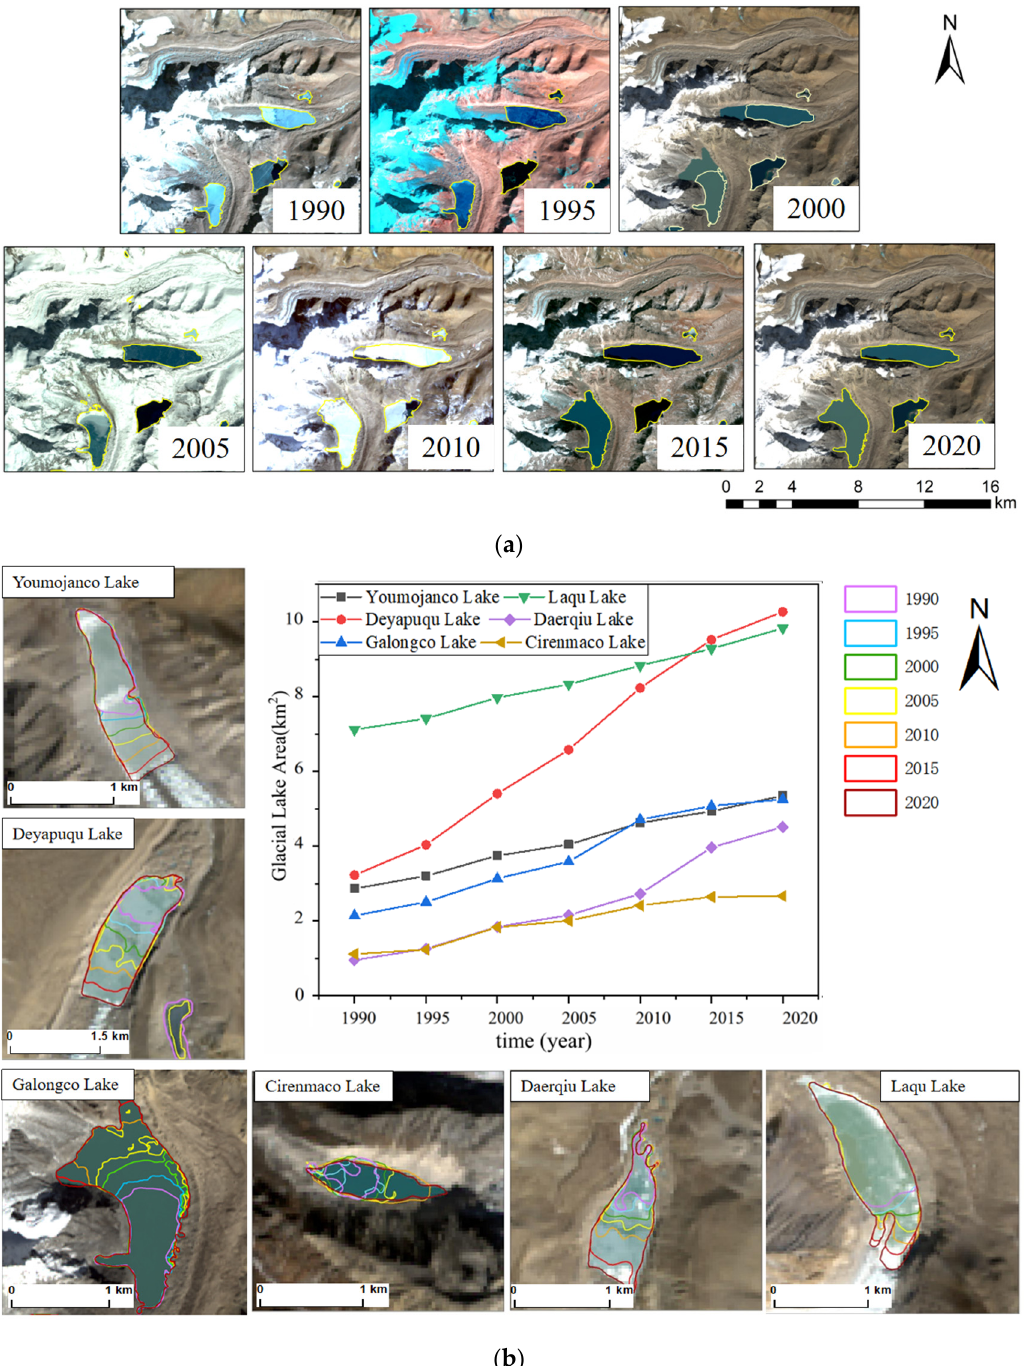
Figure 5. ( a , b ) Thirty-year comparison of glacial lake area changes in Nyalam County. Table 3. Change of glacial lakes for different elevations